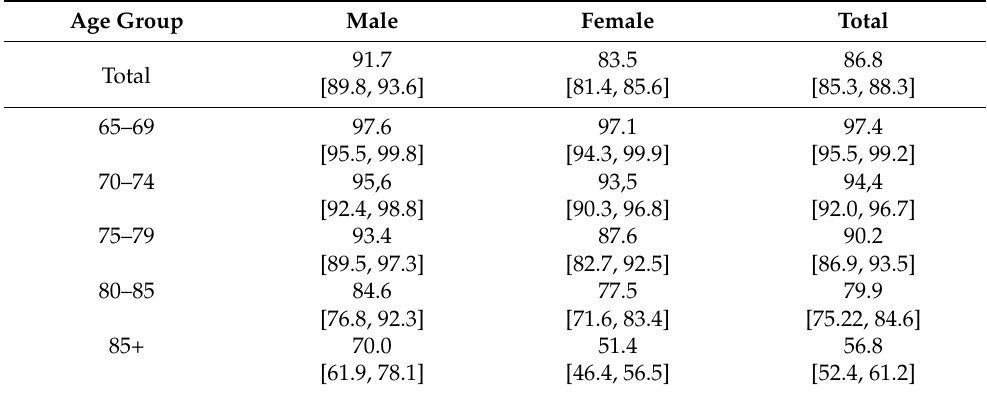
Table 4. IAFA and 95% confidence interval (in parentheses below), by sex and age group. Age Group